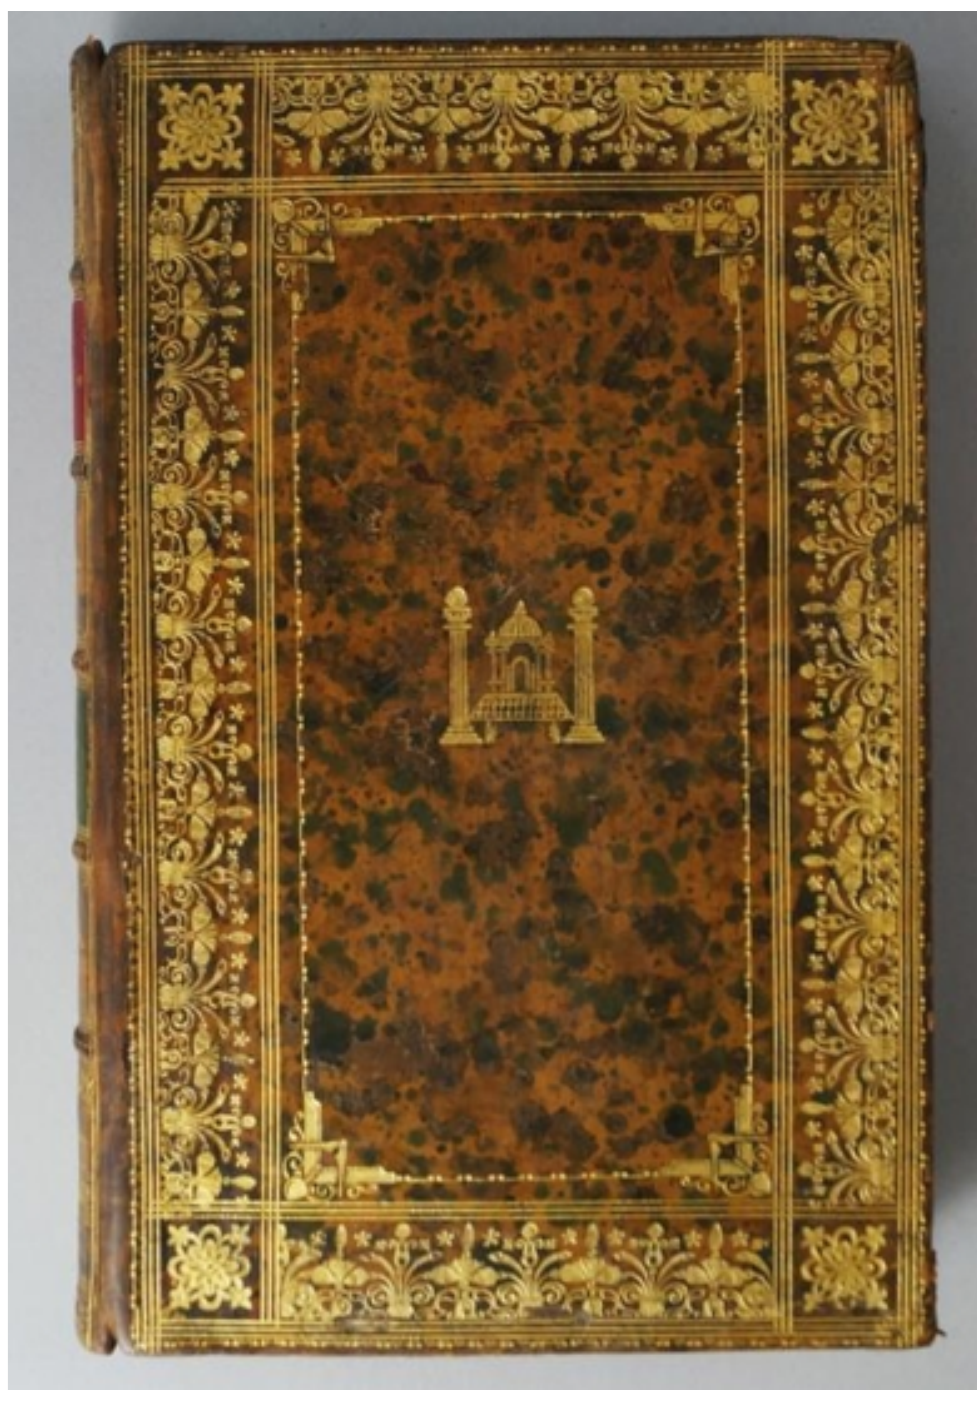
Fig. 43. Upper cover, W. A. Calcott, Candid Disquisition of the Principles and Practices of … Free and Accepted Masons (London, 1769). Gold tooled on brown sprinkled calf binding. With thanks to Roseberys